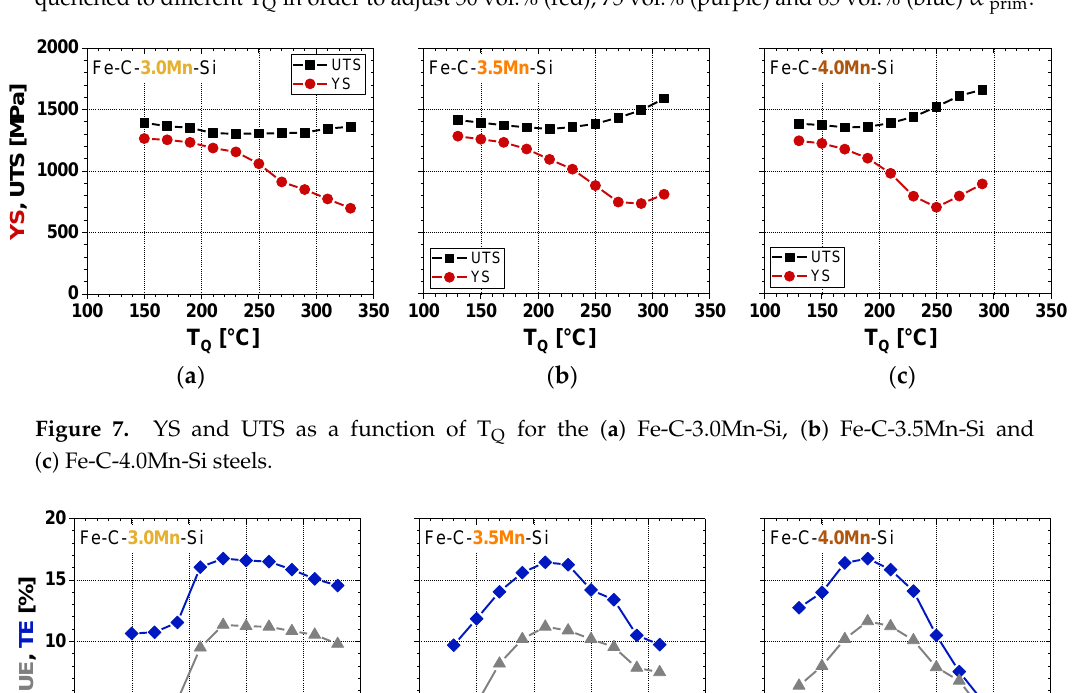
Figure 6. Stress-strain curves for the ( a ) Fe-C-3.0Mn-Si, ( b ) Fe-C-3.5Mn-Si and ( c ) Fe-C-4.0Mn-Si steels quenched to different T Q in order to adjust 50 vol.% (red), 75 vol.% (purple) and 85 vol.% ( blue) α’ prim .